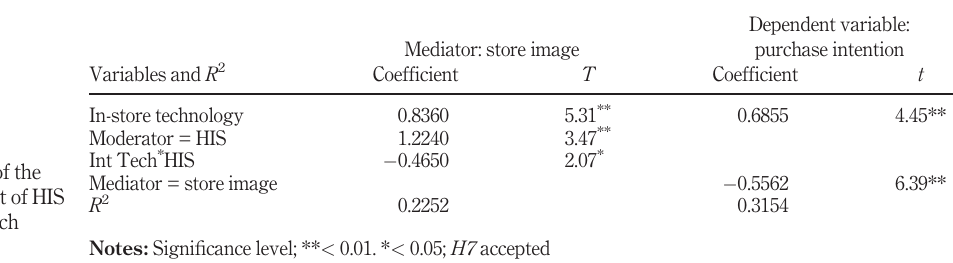
indirect effect of HIS on the